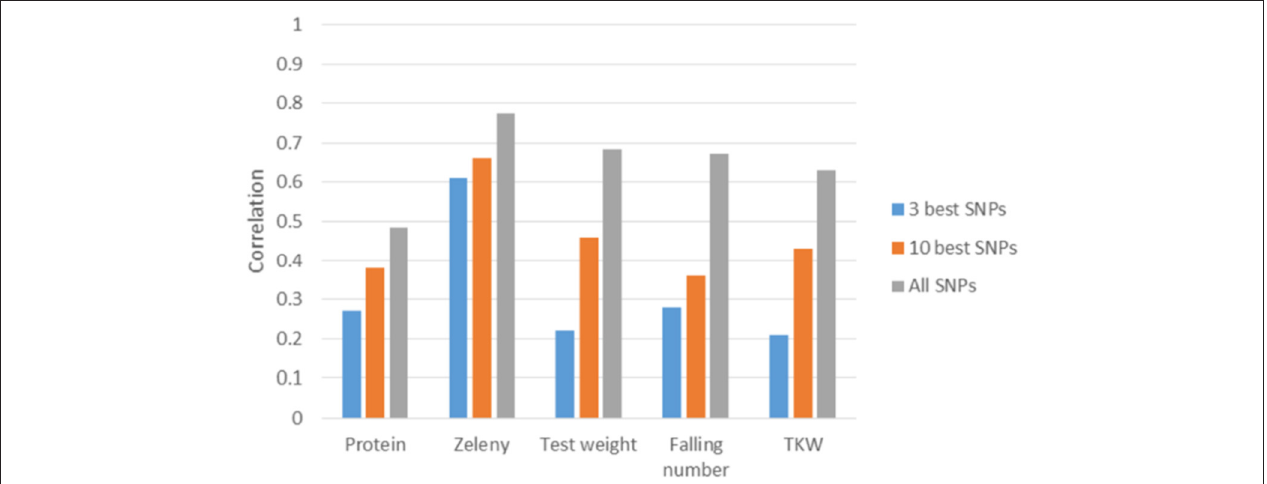
FIGURE 8 | Correlations between observed phenotypes corrected for fixed effects and GEBVs based on 5-fold cross-validations. GEBVS were predicted from the three or ten best SNPs based on single marker regression (effects re-estimated with SNP-BLUP) and from all 10,802 SNPs based on the GBLUP